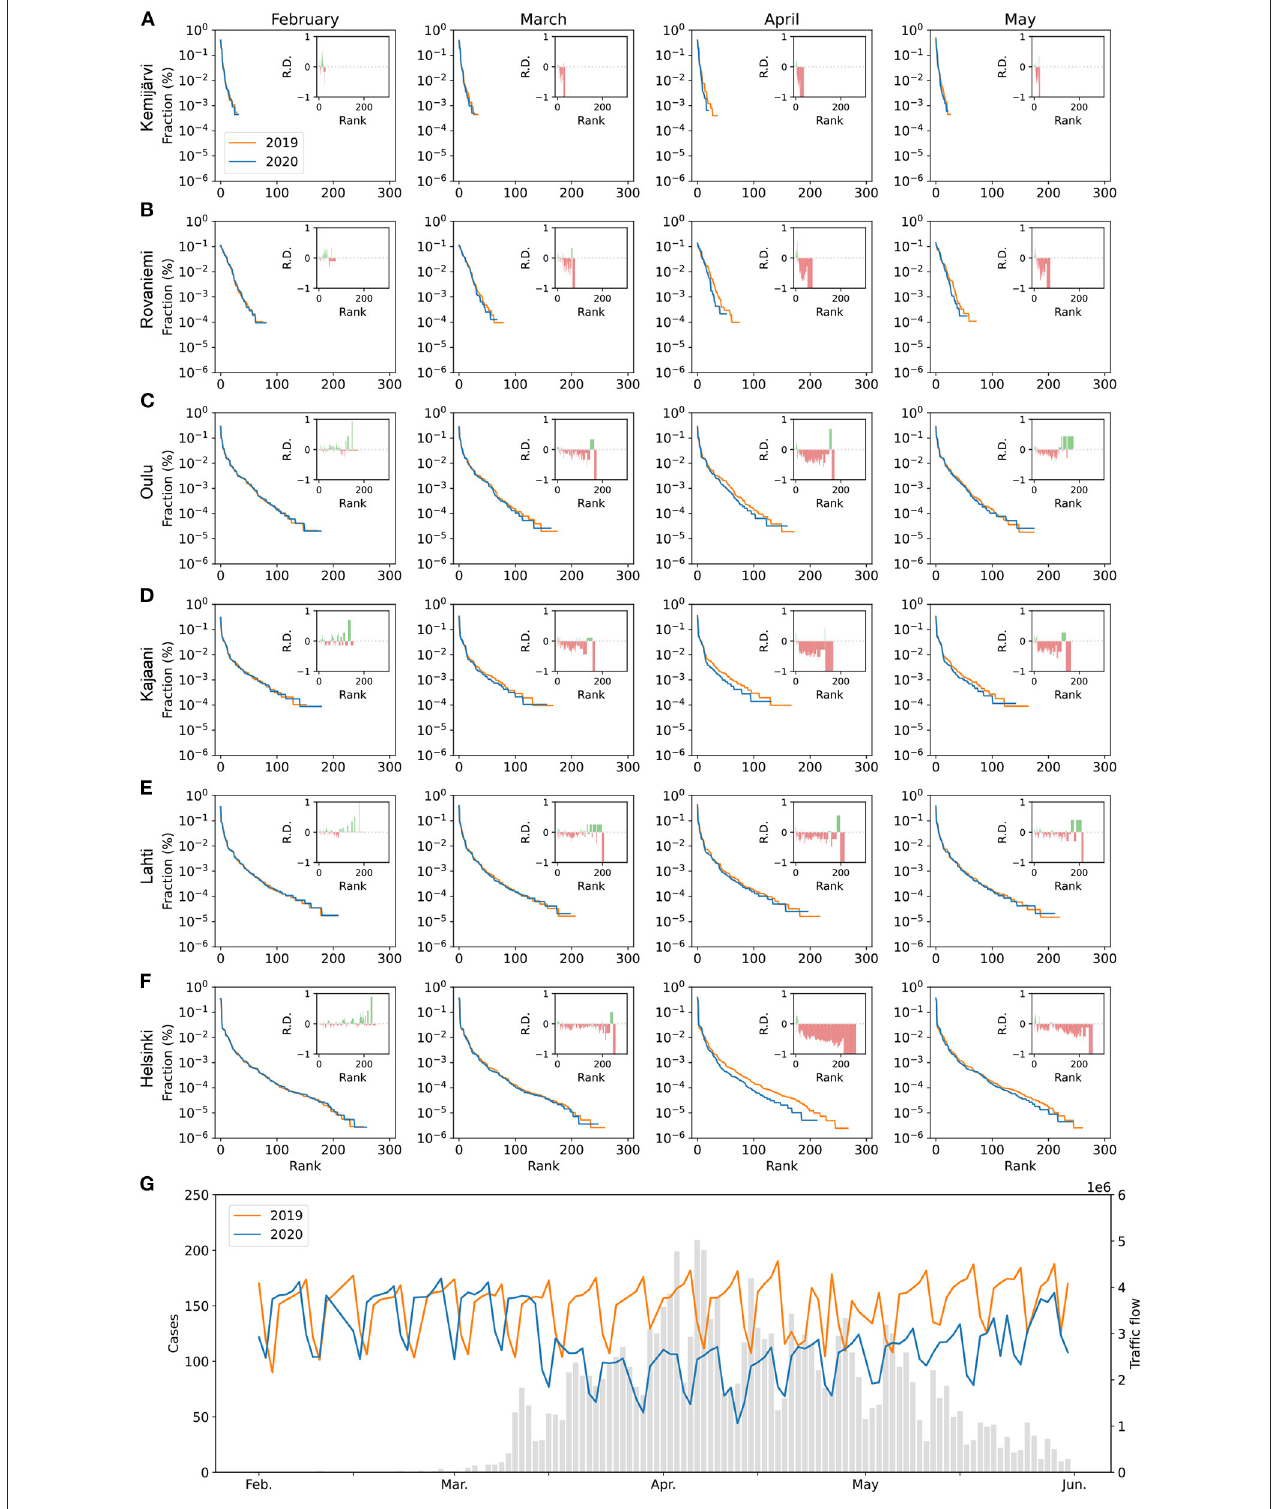
FIGURE 4 | (A–F) Month-to-month comparison of mobility signatures during February-May in 2019 (orange curves) and 2020 (blue curves). The relative differences (i.e., R.D. in insets) are the difference between fractions of trips during 2019 and fractions of trips during 2020 divided by fractions of trips during 2019. (G) The number of infected SARS-CoV-2 cases in Finland during the same time